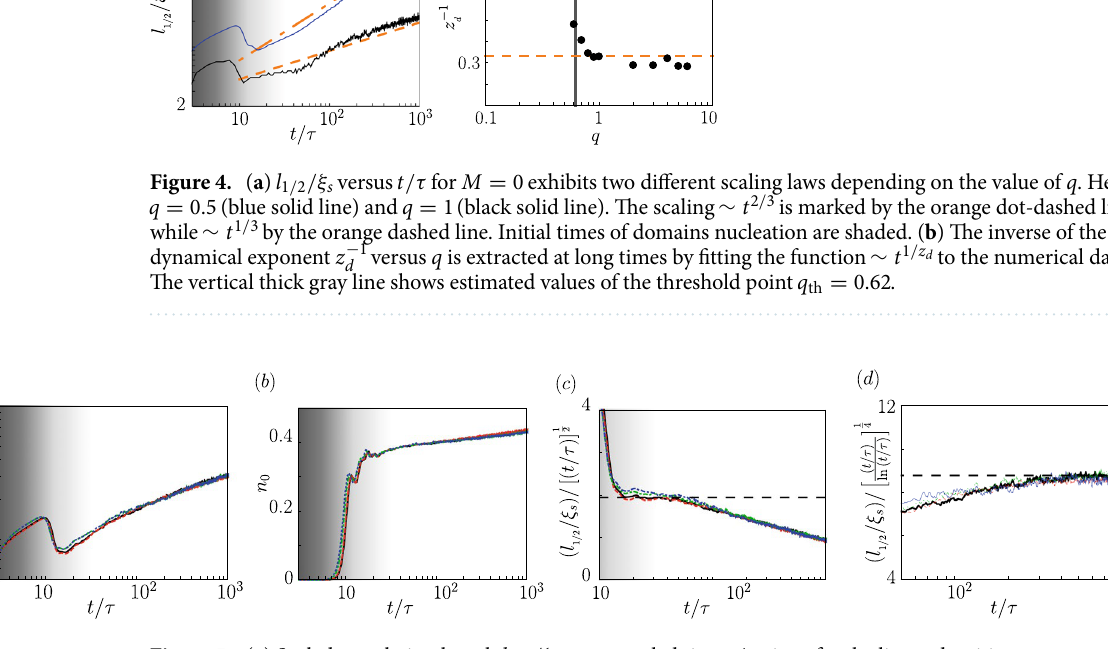
Figure 5. ( a ) Scaled correlation length l 1 / 2 /ξ s versus scaled time t /τ given for the linear densities 1 (black solid line), ρ 1 (red dashed line), ρ 1 (green dot-dashed line), 14.3 µ m 10 µ m 2 µ m ρ − − − = = = 1 (blue dot-dot-dashed line) in the effective vector field regime for N 10 4 , M 1 µ m 0.75 . ρ N / 2 and q − = = = = ( b ) Variation of n 0 in time. Regime of scaling laws referencing model A with a temporarily non conserved order parameter ( c ), and model B with a conserved order parameter at long times ( d ). The horizontal dashed line is added to guide the eye. Initial times of domains nucleation are shaded. Note, the linear scale on the vertical axis in ( c ) and ( d